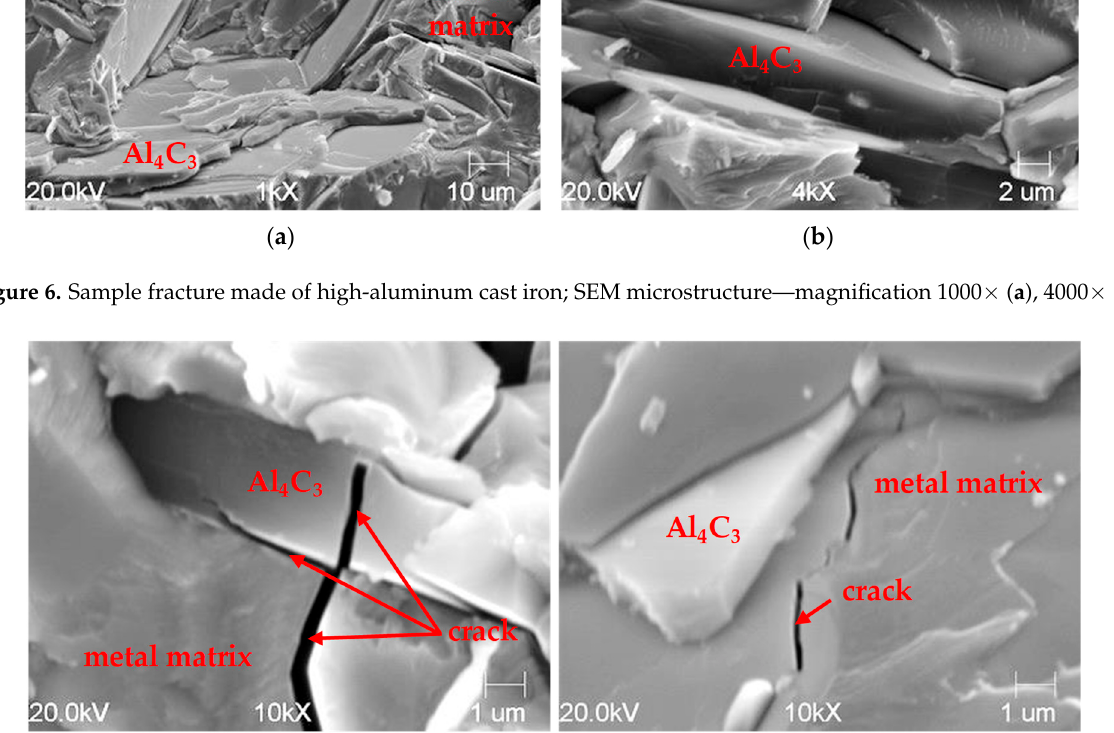
Figure 7. Sample fracture made of high-aluminum cast iron: visible cracks in carbide and metal matrix ( a ) and metal matrix ( b ) SEM microstructure.